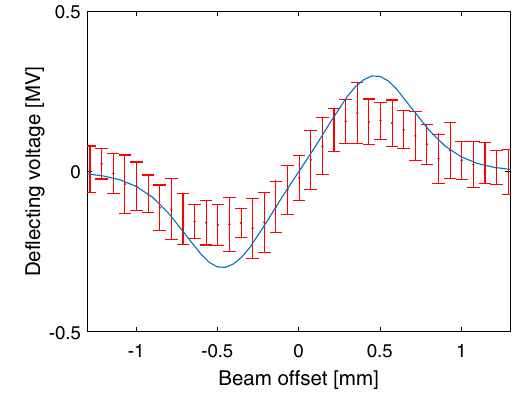
FIG. 17. Measurement of beam deflection in a horizontal scan with gap ¼ 1 . 1 mm, a longitudinal bunch length σ of 50 μ m, z and a charge of 3.2 nC (red plot). The blue plot is the The constant gradient breakdown rate measurement was performed by positioning the beam on the central axis and by exposing the structure to a certain number of pulses (flat part of the pyrodetector signal in Fig. 14). At a fixed gap, we recorded the arc-detector data and then calculated the corresponding breakdown rate. Figure 18 shows how we detect breakdowns (copper structure with gap ¼ 1 . 3 mm).